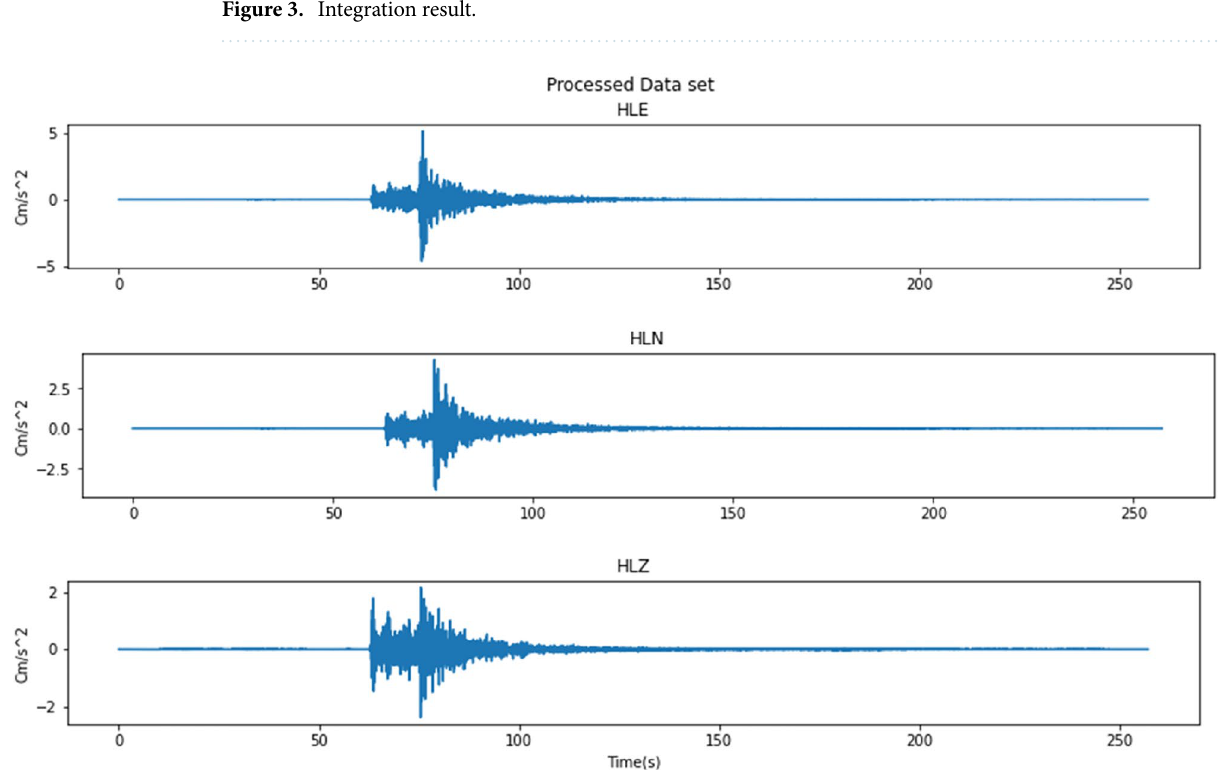
Figure 4. Processed dataset for each channel for 1